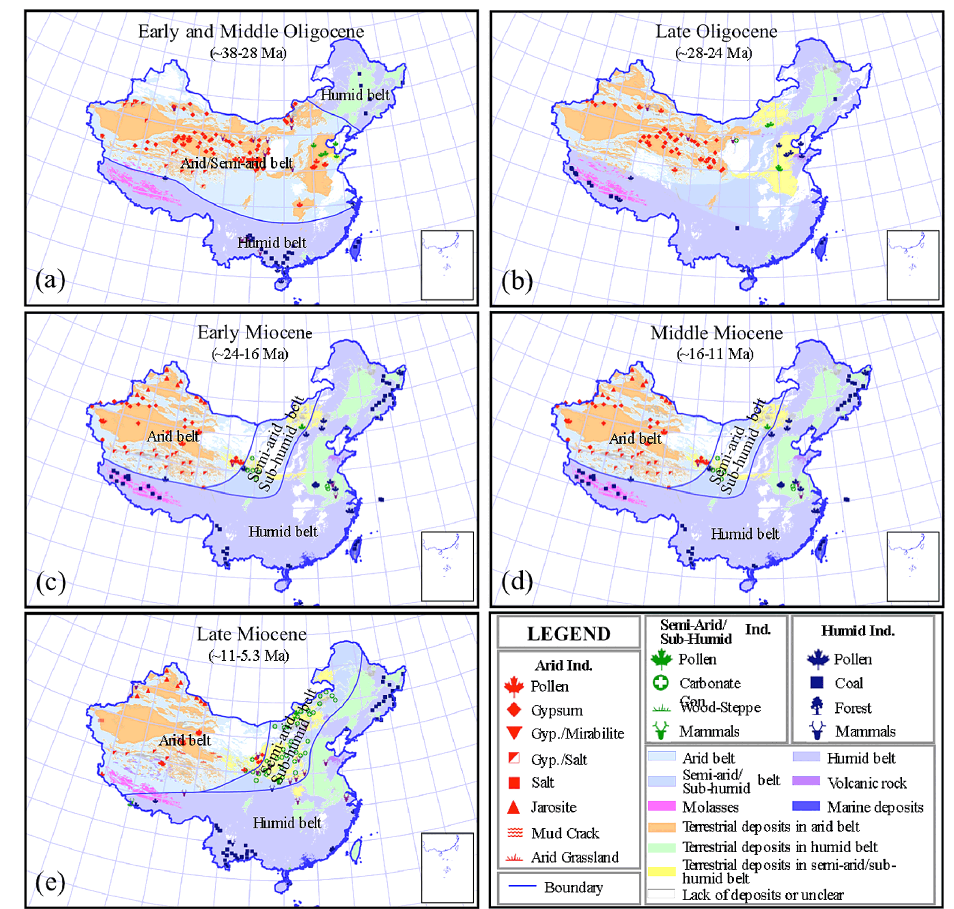
Figure 22. Paleo-environmental patterns within the Oligocene and Miocene in China (modified after Guo et al., 2008). (a) Early and middle Oligocene; (b) late Oligocene; (c) early Miocene; (d) middle Miocene; (e) late